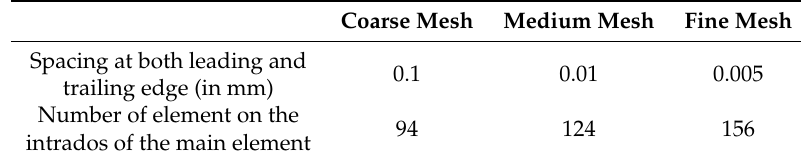
Table 4. Front wing characteristics for all three levels of mesh.